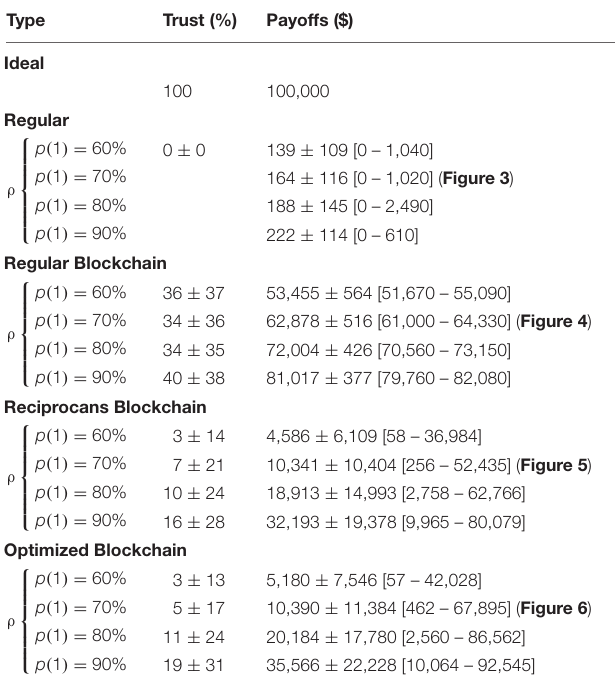
TABLE 4 | Summary of results pertaining to trust and financial gains in all the